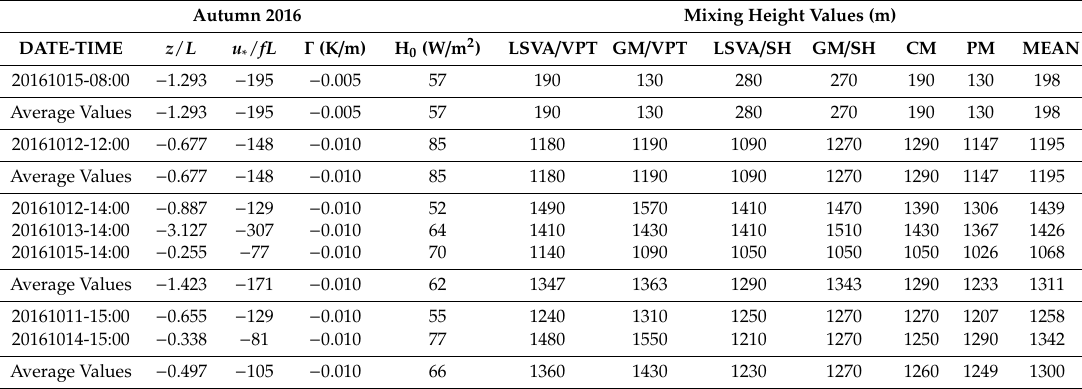
Table 6. Estimation of the Mexicali Valley convective mixing height from atmospheric soundings. Autumn 2016 Mixing Height Values